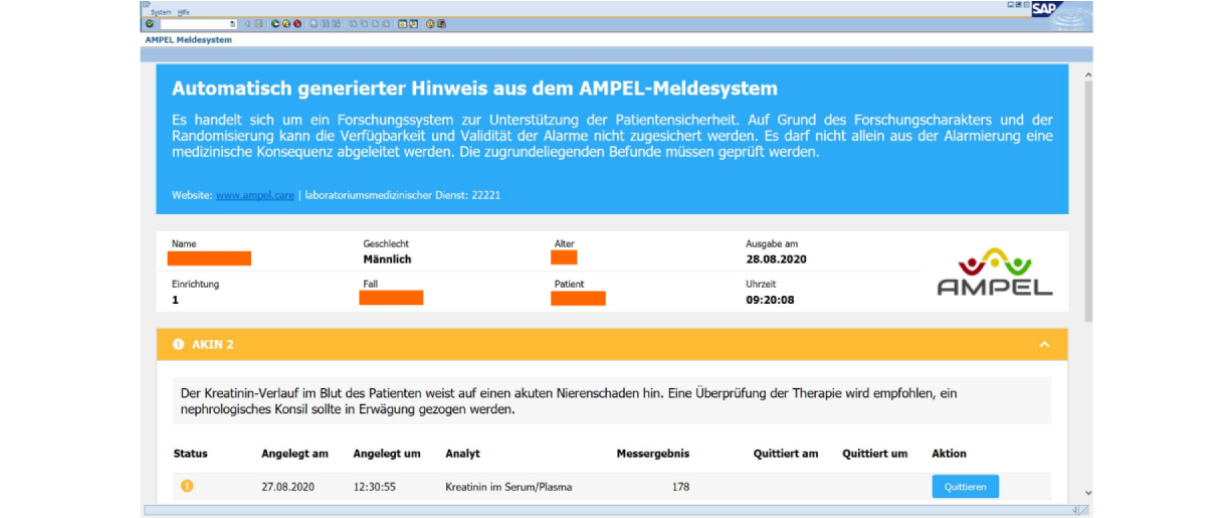
Figure 3. Screenshot of the interactive AMPEL report for a patient at the SAP R/3 visual interface. All algorithms that have been analyzed by the AMPEL system are displayed, each in a highlighted line. The user can access the specific reports by clicking on the highlighted line. In this example, the creatinine (AKIN 2) report for acute kidney injury has been chosen. The full report displays additional information to clinicians, such as internal standards or specifics from medical guidelines. The blue box at the top states that the analysis has been carried out automatically by AMPEL, an ongoing research project, and should therefore be used with